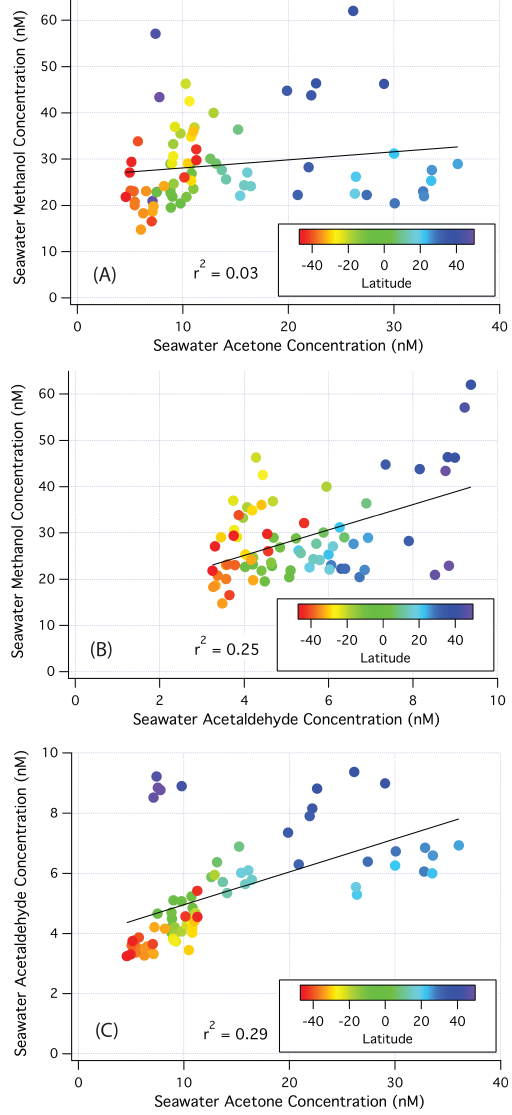
Figure 12. Near surface seawater concentrations of (A) methanol vs. acetone, (B) methanol vs. acetaldehyde (B) , and (C) acetalde- hyde vs. acetone, color-coded by latitude. Correlations between sea- water concentrations are much lower than those between air con- centrations, implying different oceanic production and consumption pathways of these